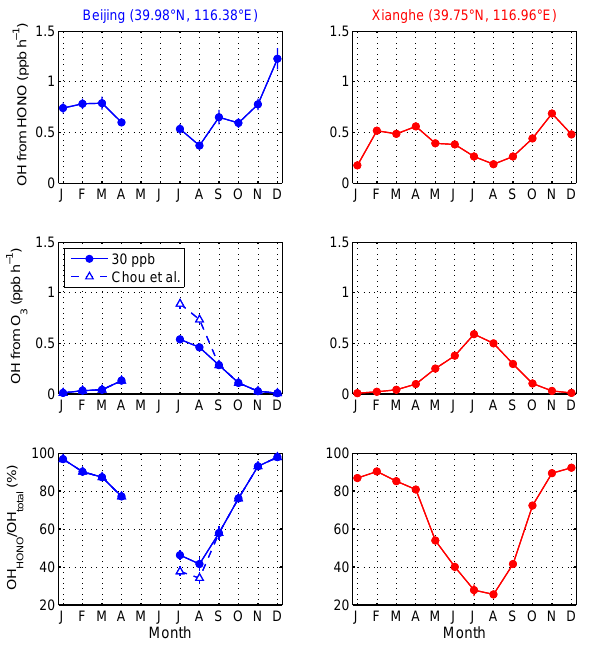
Fig. 15. Seasonal variation of the OH production from HONO ) in the 0–200m layer at Beijing (OH HONO ) and O 3 (OH O 3 (left/blue curves) and Xianghe (right/red curves) at local noon. Data correspond to monthly averages over the time interval of ± 2h around local noon. OH total is equal to OH HONO + OH O . The error 3 bars correspond to the standard deviation of the